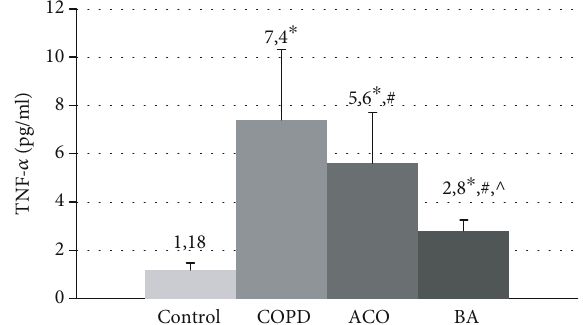
Figure 6: The mean TNF- α concentrations in the blood serum in patients with COPD, asthma-COPD overlap, and bronchial asthma. COPD: chronic obstructive pulmonary disease; ACO: asthma-COPD overlap; BA: bronchial asthma; ∗ p < 0 : 05 versus healthy